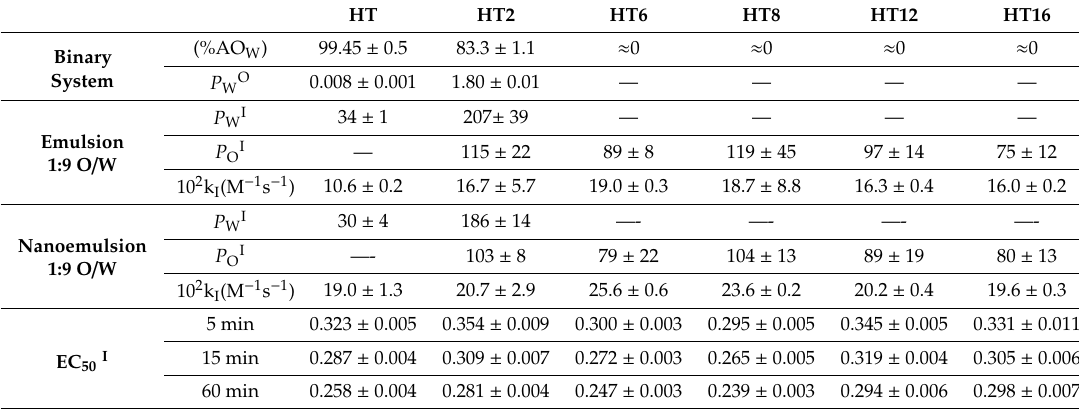
Table 1. AO percentages in aqueous phase (%AO W ) and P WO values in binary fish oil-water systems. P OI and P WI values and the rate constant in the interfacial region, k I , in fish oil emulsified systems. EC 50 (mole AO / mole DPPH • ) and anodic potentials E pa versus Ag–AgCl measured at a glassy carbon electrode for 10 − 4 mol L − 1 solutions of compounds in bu ff er solution in the absence and presence of 2% Tween 80. Emulsion droplet sizes of emulsified systems containing AOs in